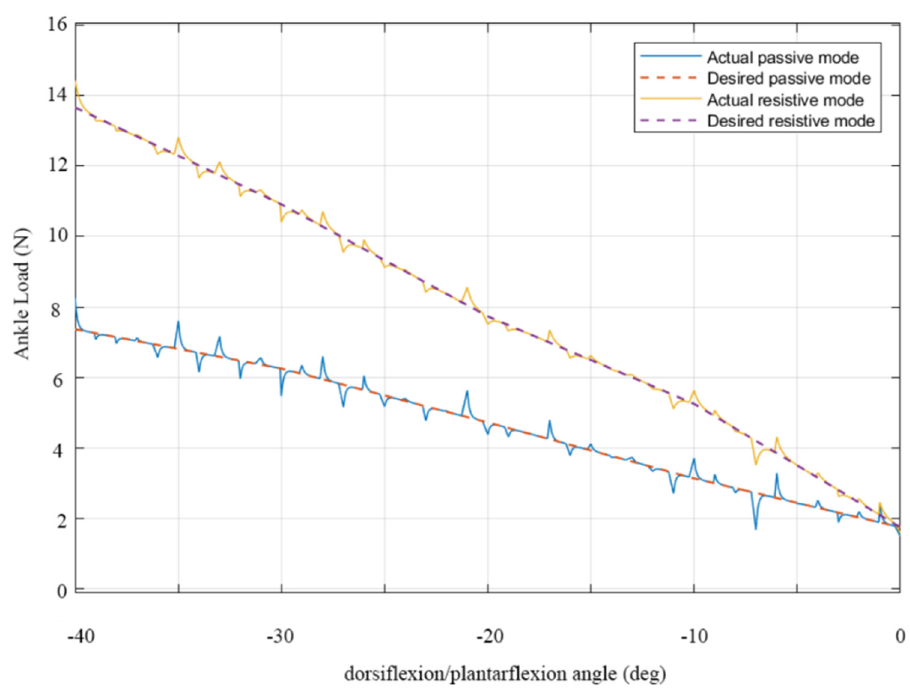
Figure 11. Desired and computed ankle load for simulated passive and resistive modes values of a controlled ankle assisted motion exercise.